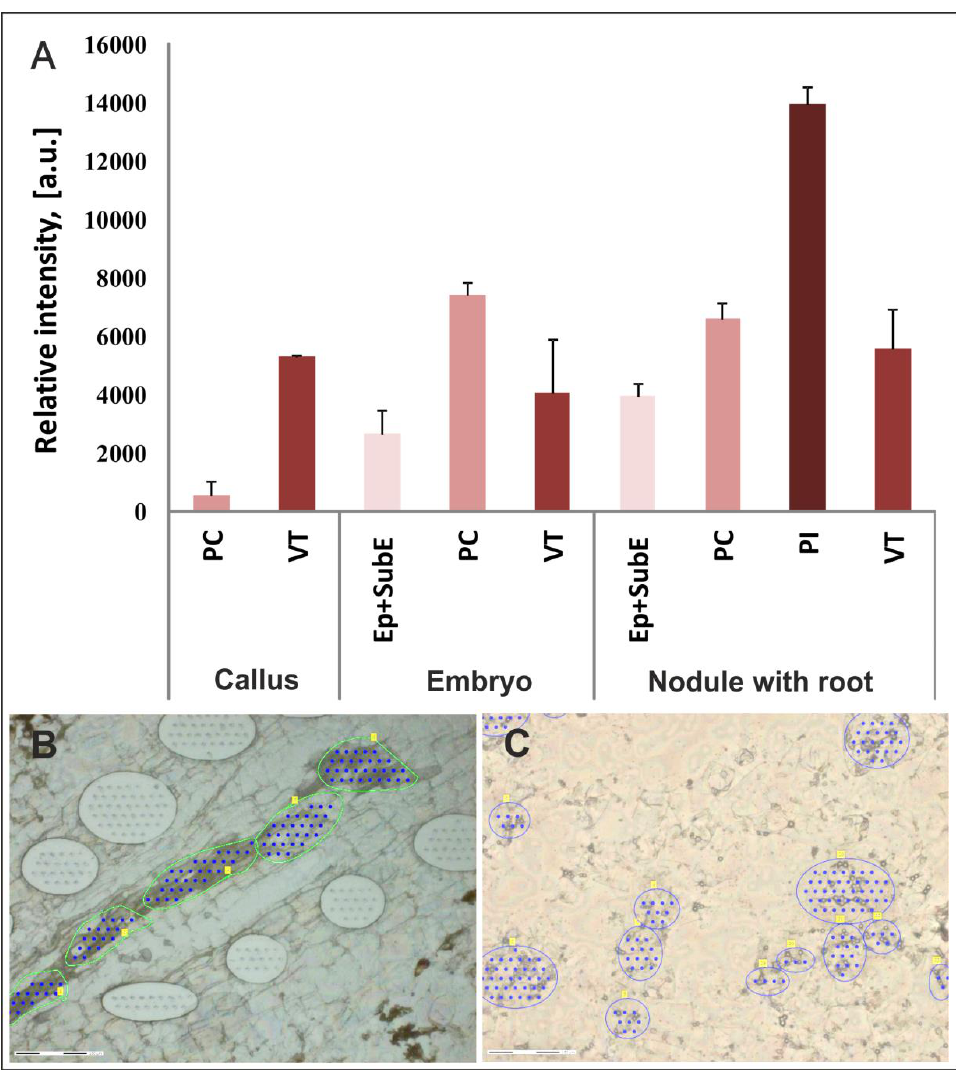
Figure 6. Matrix-assisted laser desorption ⁄ ionization mass spectrometric (MALDI-MS) data of stepharine (m⁄z 298.142) from microdissected tissue of the S2 line. ( A ) Diagram of stepharine content in the microdissected tissues. ( B ) Light microscopy image of microdissected portions of the vascular tissue with companion cells. ( C ) Light microscopy image of microdissected portions of the parenchymal cells with inclusions. PC, parenchymal cells; VT cells, vascular tissue with companion cells; PI cells, parenchymal cells with inclusions; Ep + SubE, epidermal and subepidermal tissue; (a.u.), arbitrary units. Blue and green lines indicate regions of extracted cells and blue dots marks the location of laser impulses. Bars, 150 µM.